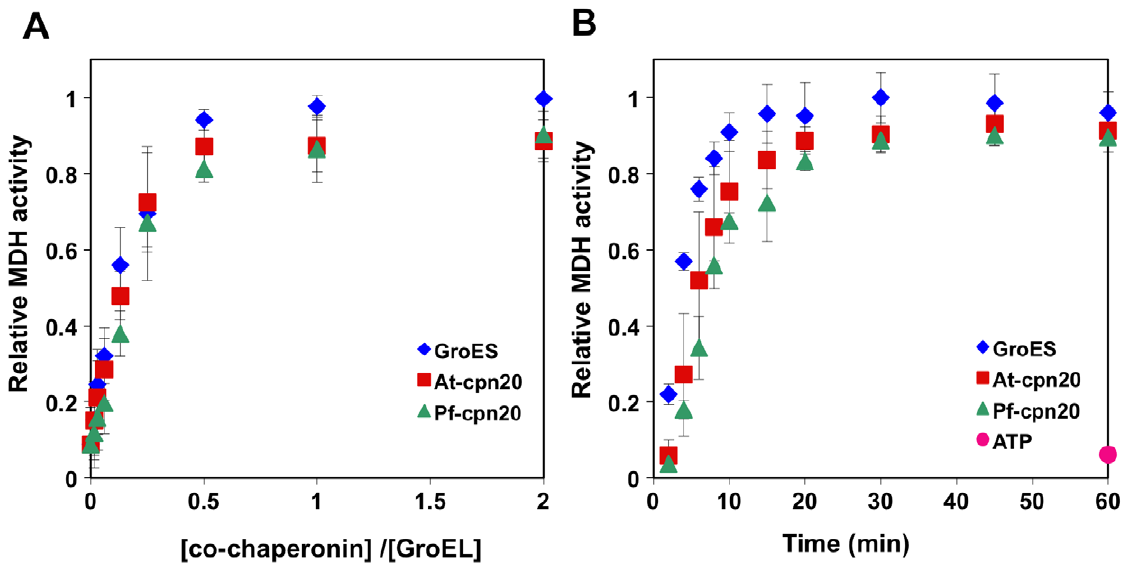
Figure 2. Refolding of denatured MDH by GroEL and Pf-cpn20. Urea-denatured malate dehydrogenase was refolded by GroEL with the help of Pf-cpn20, using At-cpn20 and GroES as control co-chaperonins. A) Refolding yields as a function of the co-chaperonin/GroEL protomer ratio. The refolding reaction was carried out for 30 minutes with 10 m M GroEL and increasing co-chaperonin concentration (0.16 to 20 m M), as described in Materials and Methods. Refolding is expressed relative to the highest yield obtained with GroES. B) Refolding yield as a function of time carried out with 10 m M GroEL and a sub-saturating co-chaperonin concentration (2 m M) Values represent the average of 3 independent experiments + / 2 standard deviation.